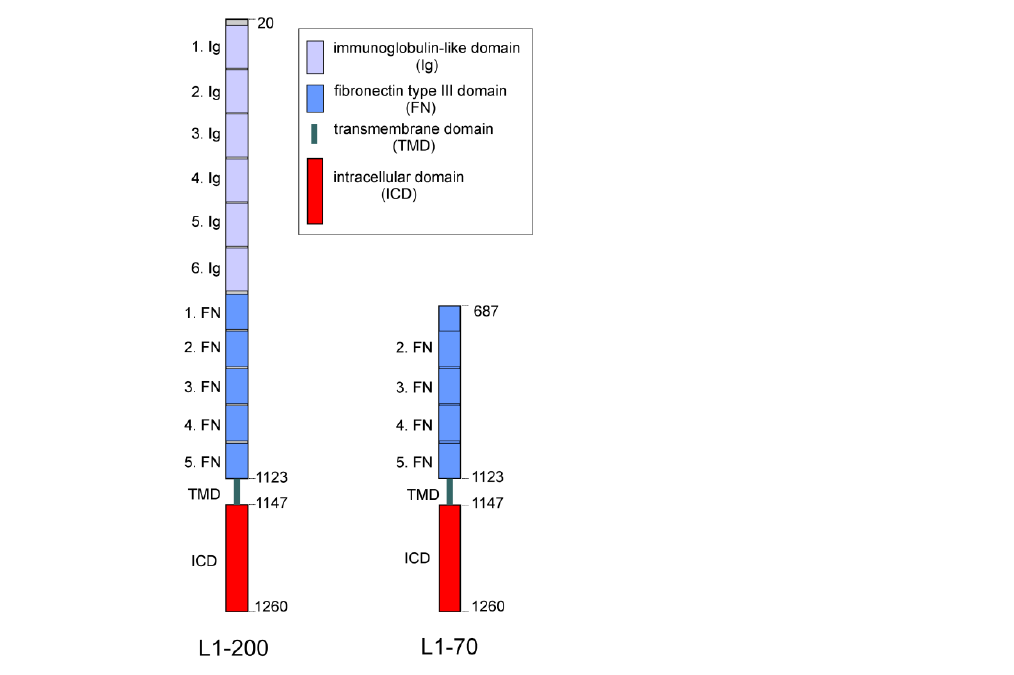
Figure 1. Schematic representation of full-length L1 and L1-70. Full-length L1 (L1-200) consists of an extracellular portion with six Ig-like (Ig) and five FNIII (FN) domains, a transmembrane domain (TMD) and an intracellular domain (ICD). L1-200 is cleaved by a proteolytically active myelin basic protein in the first FNIII domain at position 687, leading to the generation of L1-70 which comprises part of the first FNIII domain, the second, third, fourth and fifth FNIII domains, as well as the TMD and ICD (adapted with permission from [41]; 2023, Kleene, Loers and Schachner).